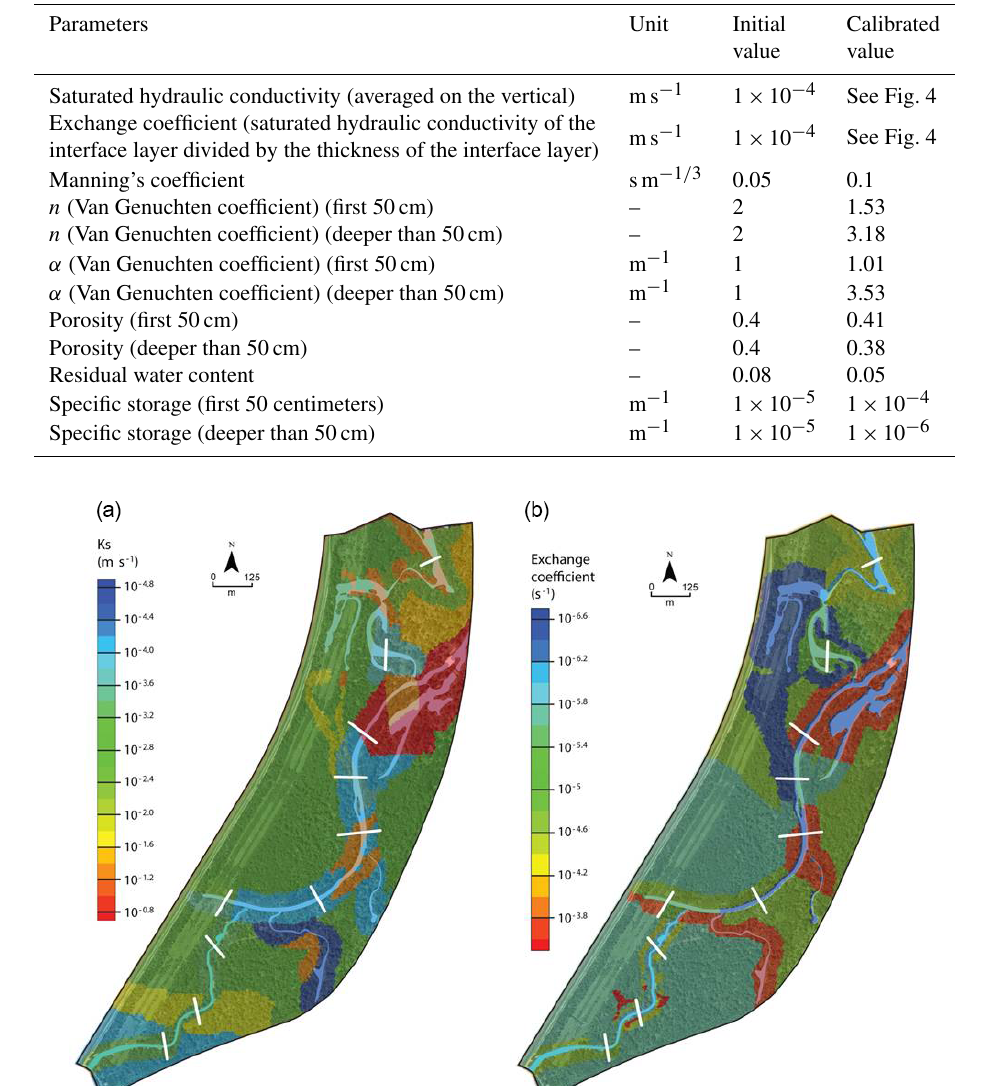
Table 1. List of parameters that were calibrated with initial and final value after calibration. Only the saturated hydraulic conductivity and the exchange coefficient were considered variable in space. The other parameters are considered homogeneous for the whole simulated domain.